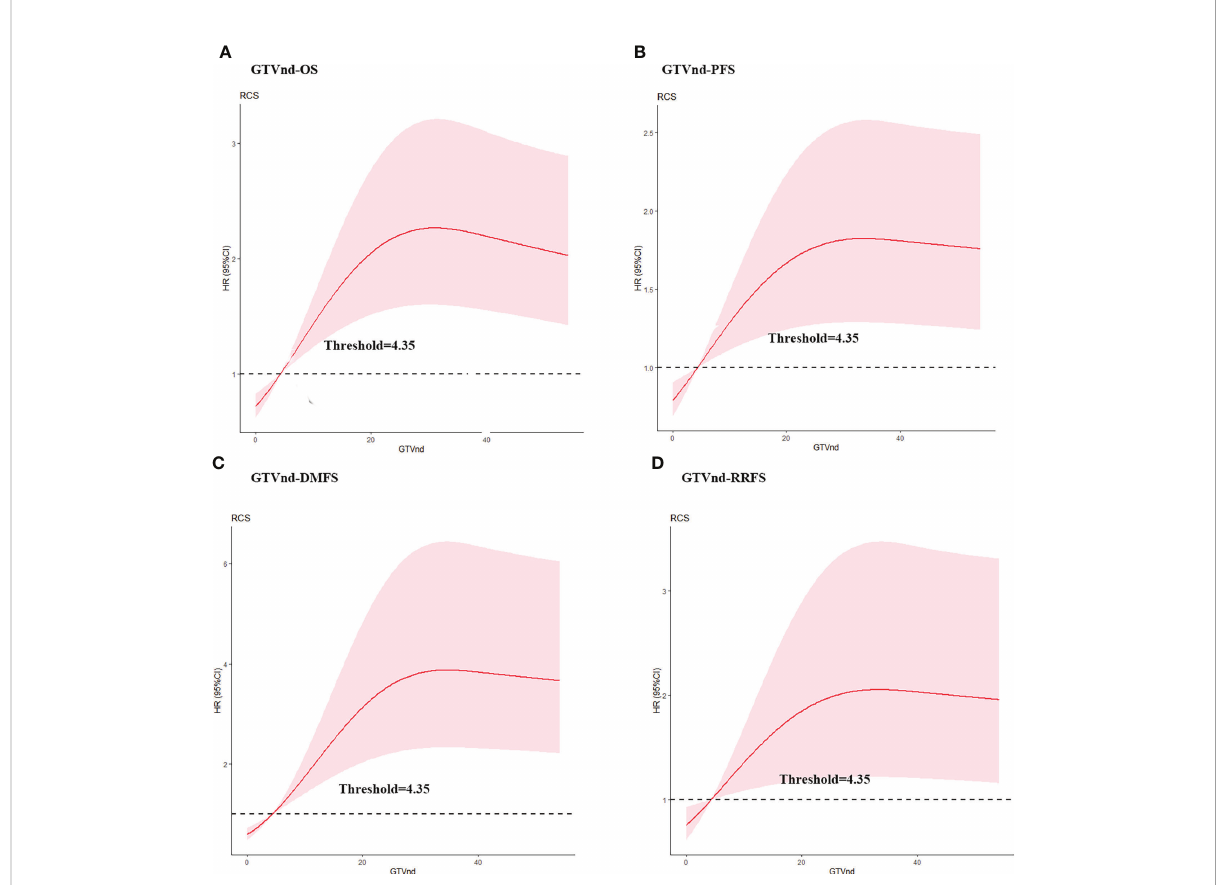
FIGURE 1 Estimated hazard ratio (HR) (red solid line) with 95% con fi dence intervals (red dash area) for the association of gross volume of metastatic lymph nodes (GTVnd) with (A) overall survival (OS), (B) progression free survival (PFS), (C) distant metastasis free survival (DMFS), and (D) regional recurrence free survival (RRFS) in ESCC patients treated with dCCRT. The risk (in HR) of OS, PFS, DMFS, and RRFS increased along with the augment of